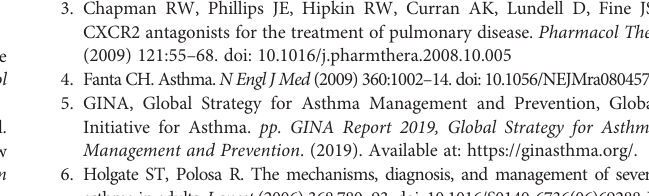
SUPPLEMENTARY FIGURE 1 | Mice atopy induced by OVA challenge. IgA, IgG and IgE antibodies levels were measured by ELISA. n = 8 for each group, * for P < 0.05; ** for P < 0.01. SUPPLEMENTARY FIGURE 2 | Ladarixin treatment did not reduces mucus overproduction. Mucus production was evaluated after four daily challenges with OVA. (A) Histogram showing area positive for mucus, which indicates goblet cell hypertrophy. (B) Lung histological sections (Periodic acid-schiff dye). Arrows head indicate goblet cells hypertrophy and mucus overproduction. n = 8 for each group, ** for P < 0.01. SUPPLEMENTARY FIGURE 3 | Ladarixin effect over lung histological sections, viral titer and IL-10 production in lung tissue. (A) In fl ammation score, derived from histological analyses from lung tissue, obtained at day 10 of Cs exposure. (B) Lung viraltiterfrominfectedmicegroupsonday12ofassay. (C) IL-10levelsinlungtissue of mice obtained on day 12 of assay. (D) Representative histological sections of lung (H&E dye) for each group obtained at day 10 of Cs exposure. n = 6 for each group, * represents signi fi cant differences compared to Air group except when indicated with a solid line * for P < 0.05 and ** for P <